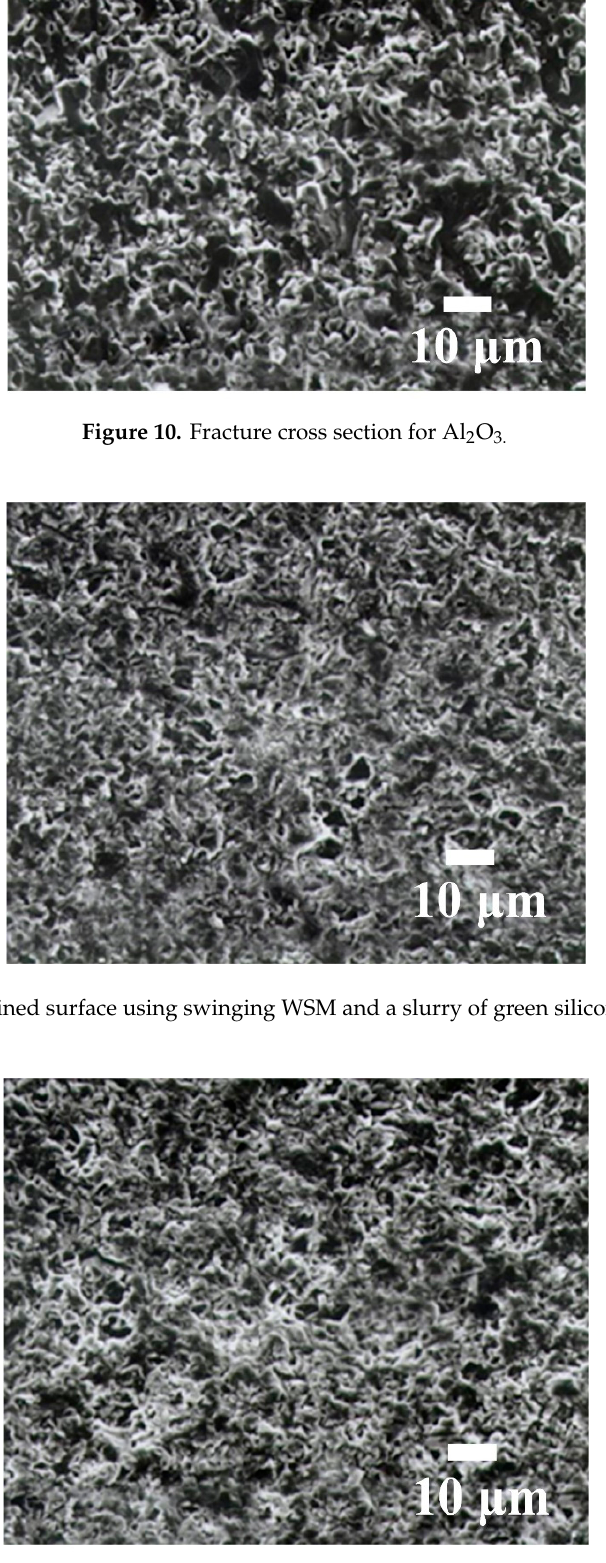
Figure 12. Machined surface using non-swinging WSM and a slurry (GC).